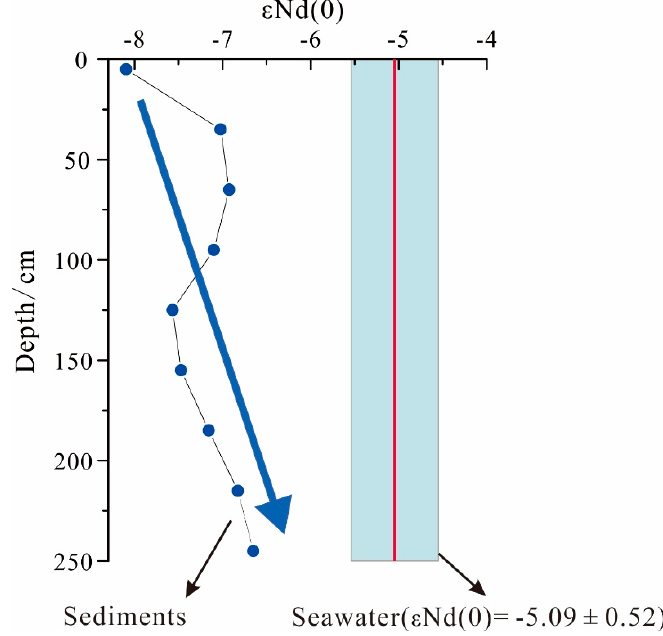
Figure 7. Profile distribution of ε Nd(0) in GC1601 and seawater.